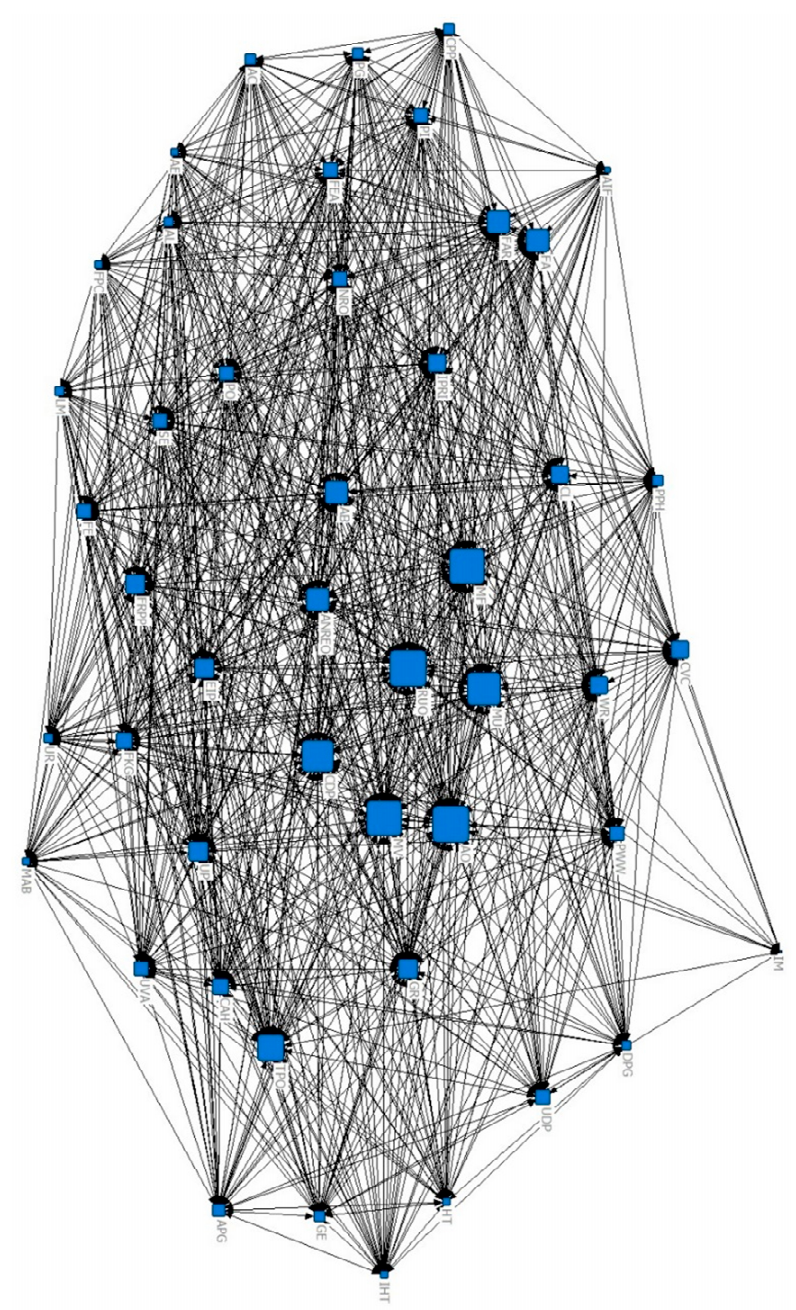
Figure A1. Illustration of actor network of transition process by Ucinet.